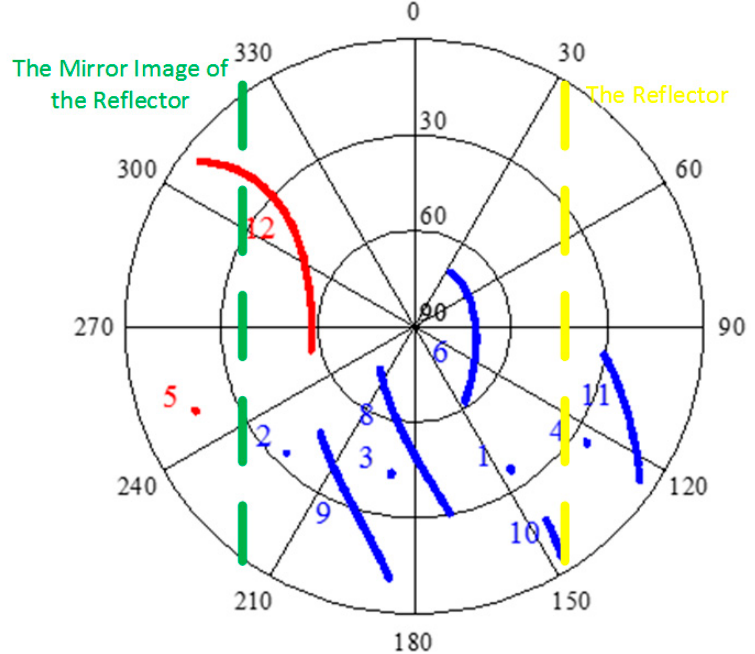
Figure 11. The reflector and the sky plot of the satellites.